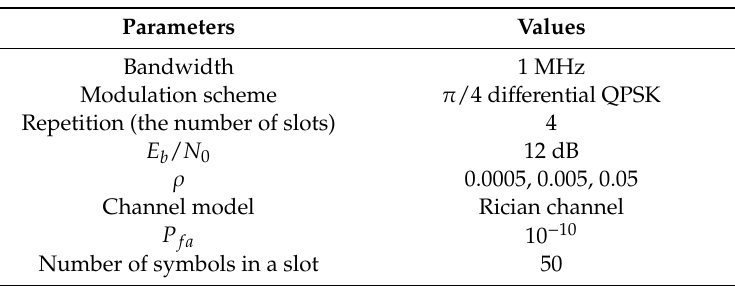
Table 1. Experiment parameters.